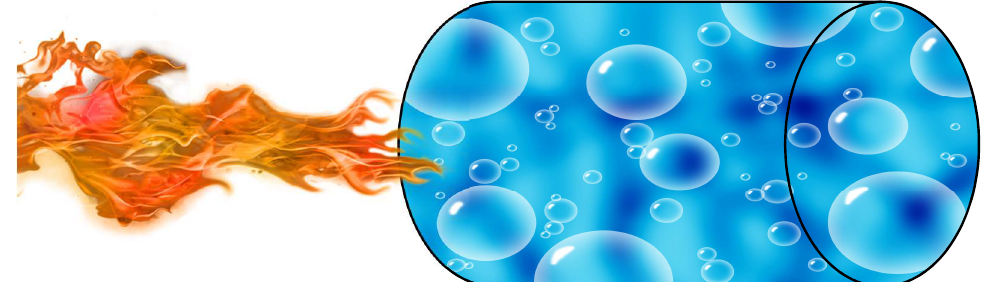
Figure 2. Sketch of Propane tank exposed to Heptane jet fire.